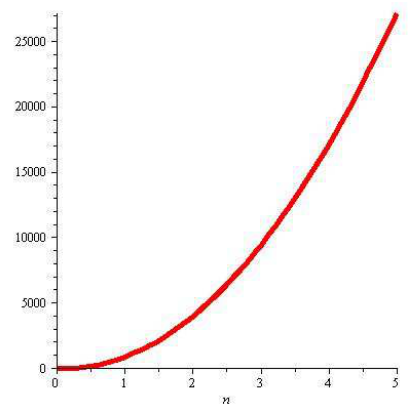
Figure 5: Graph of HM ( OX n )